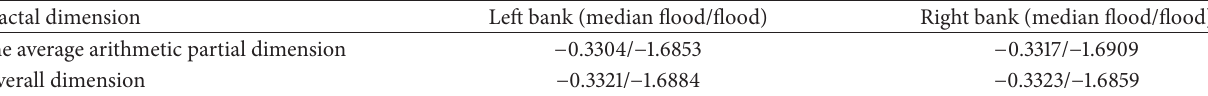
Table 7: The result of average arithmetic dimension to overall and partial fractal of Chongqing city of Yangtze River. Fractal dimension Left bank (median flood/flood) Right bank (median flood/flood) The average arithmetic partial dimension − 0.3304/ − 1.6853 − 0.3317/ − 1.6909 Overall dimension − 0.3321/ − 1.6884 − 0.3323/ −